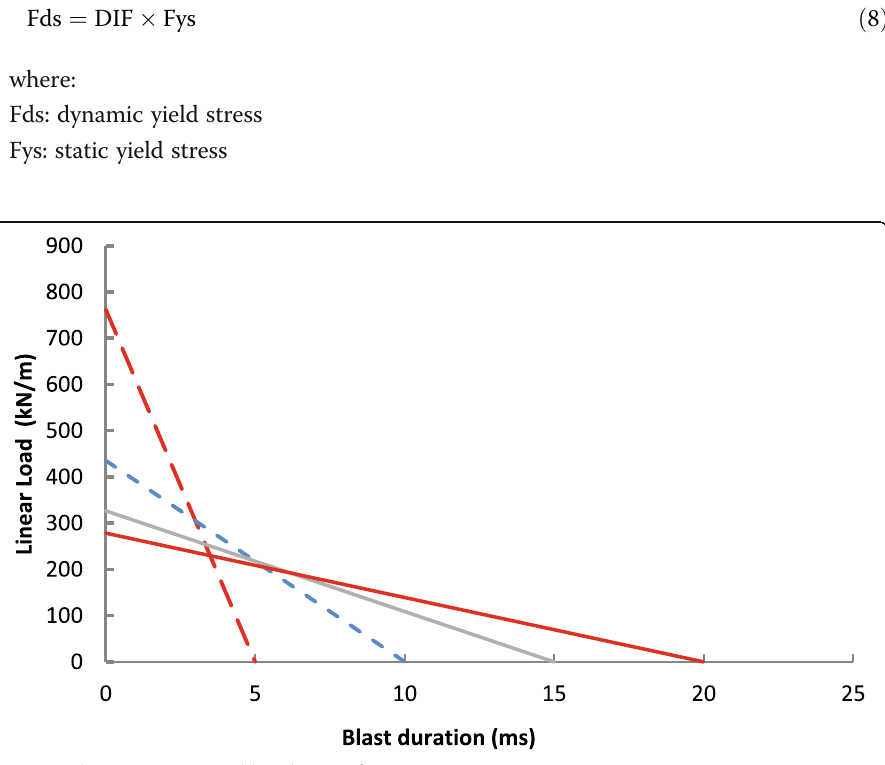
Fig. 22 Blast pressure versus blast duration for connection